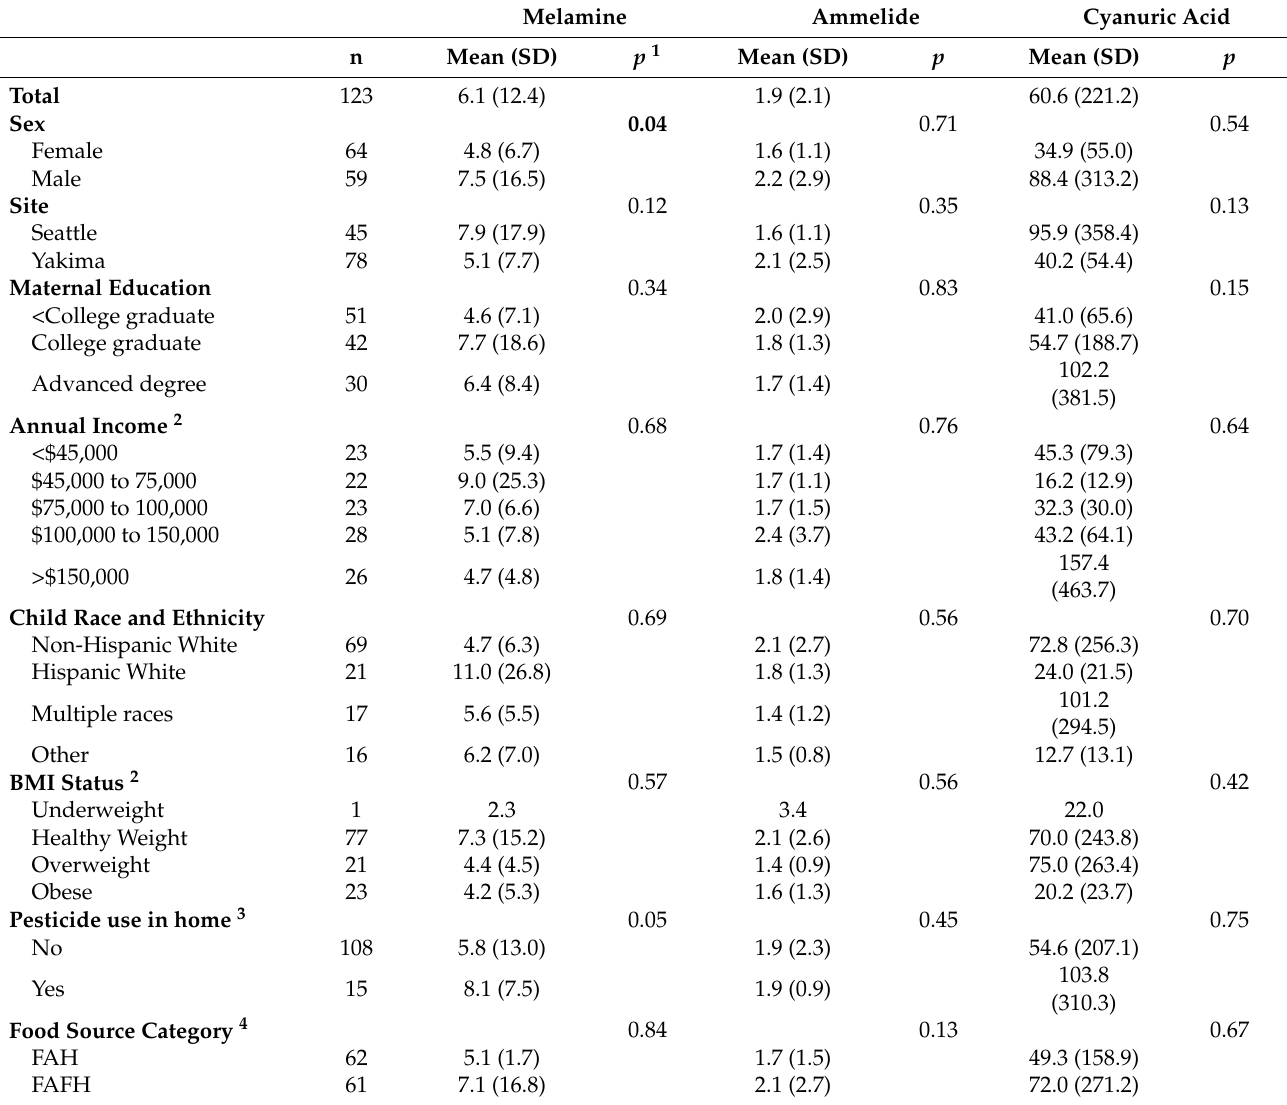
Table 2. Concentrations of melamine, ammelide, and cyanuric acid (ng/mL) in spot urine samples among children aged 4–6 in the PATHWAYS GAPPS cohort and by sociodemographic subgroup. Melamine Ammelide Cyanuric